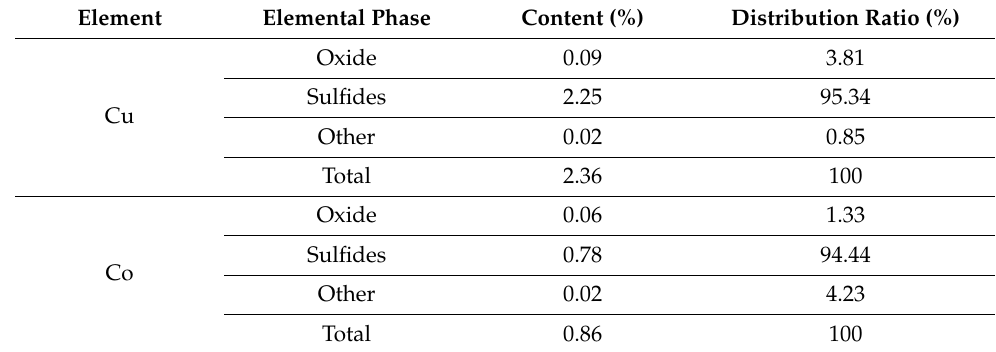
Table 3. The chemical phases of ore.